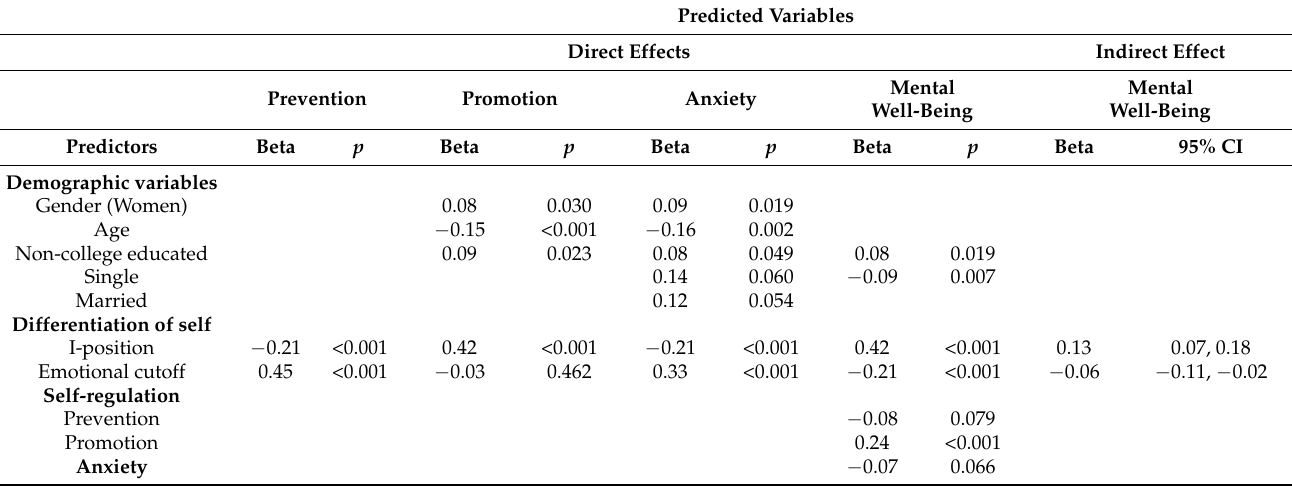
Figure 1. Summary of Mediation Model Using Path Analysis Model (N = 460). ** p < 0.01. *** p < 0.001. Table 4. Summary of Mediation Model (N = Table 4. Summary of Mediation Model (N = 460).